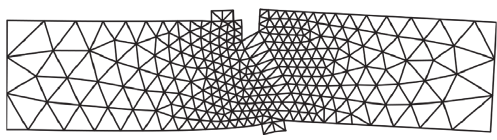
Figure 18: Deformed mesh for the four-point beam.